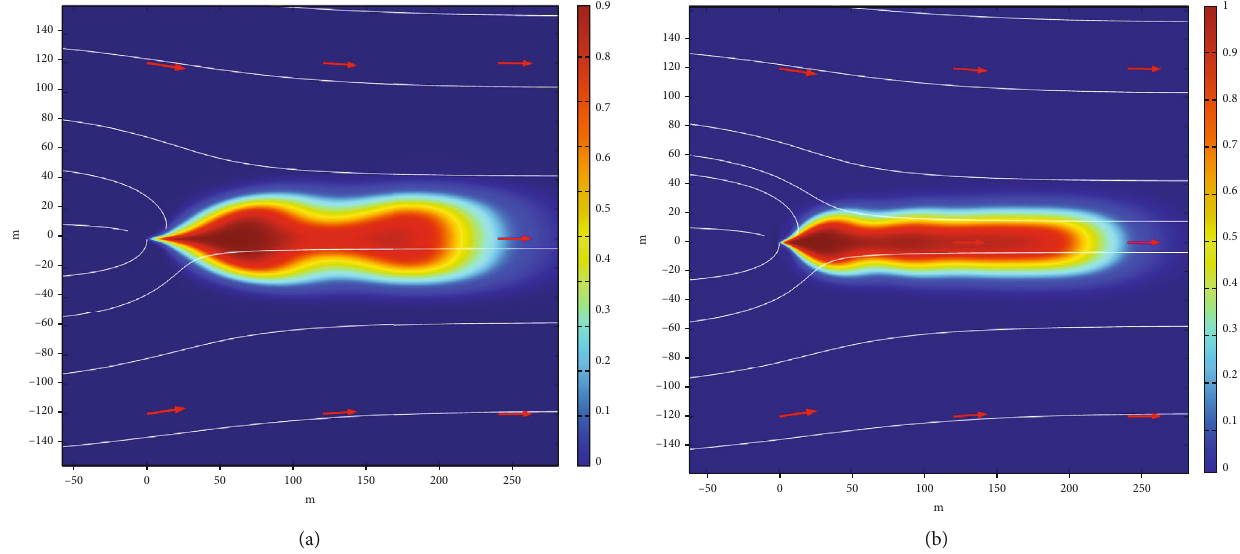
Figure 8: Concentration distributions in a 2D horizontal plane at t 2 = 360 day. (a) t pump = 180 days, and (b) t pump = 90 days .